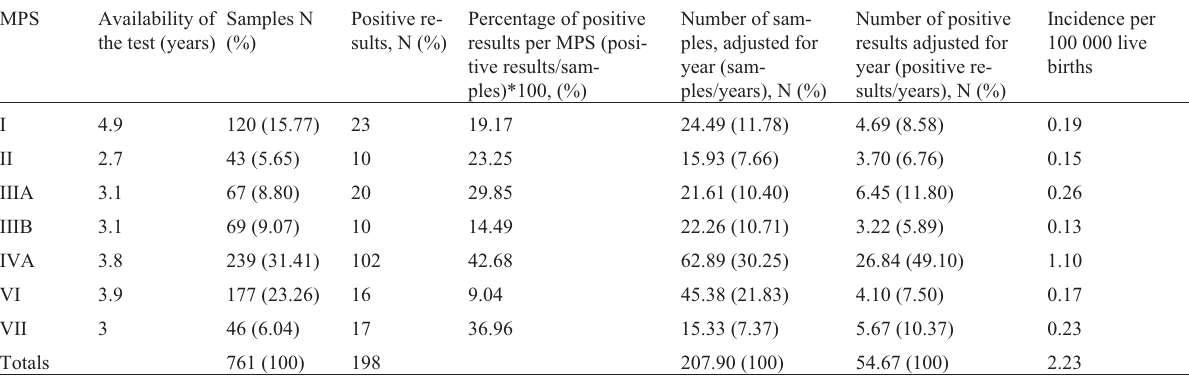
Table 2 - Data from probes performed for each type of MPS.